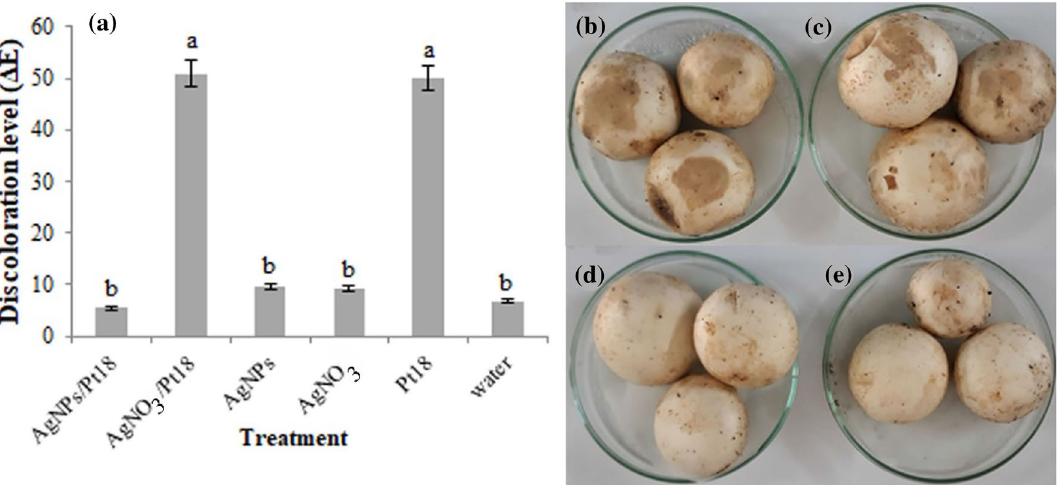
Figure 9. Effect of AgNPs biosynthesized by Pseudomonas canadensis Ma1 on ( a ) discoloration level (ΔE) of Agaricus bisporus caps inoculated with Pseudomonas tolaasii Pt18 (Pt) compared with controls. Representative mushrooms caps inoculated with ( b ) P. tolaasii Pt18 alone, ( c ) AgNO 3 , ( d ) AgNPs, and ( e ) sterile distilled water are shown. The graph represents the mean of three replicates. Error bars indicate the SE of the three replicates. Different letters indicate significant differences between treatments (p =